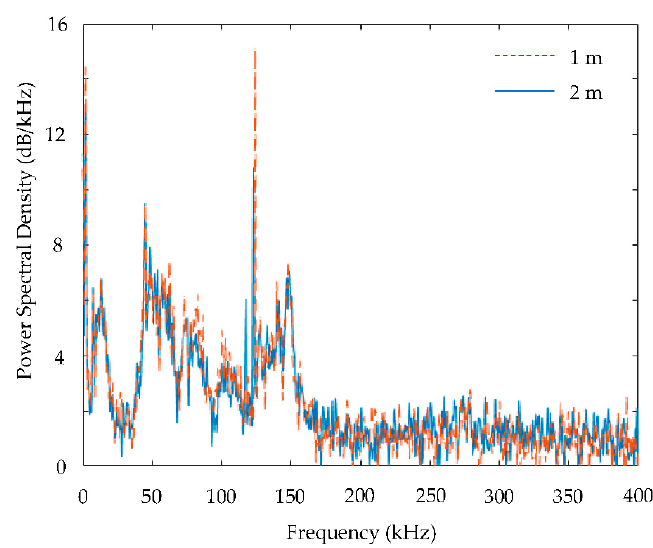
Figure 11. Comparison of the power spectral densities of the leakage-induced signal in the different distances (L 1 = 1 m, 2 m) away from the leak source.